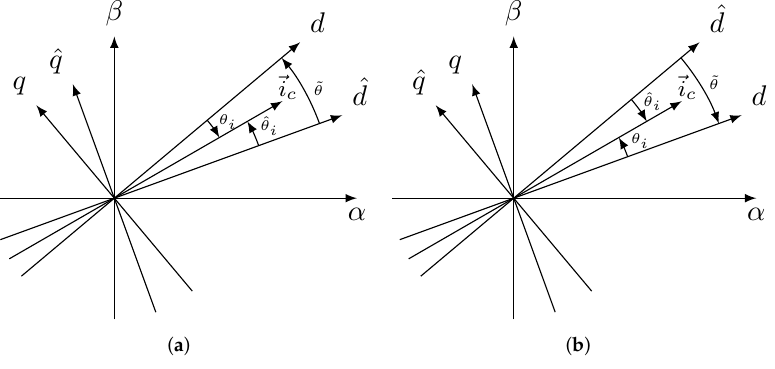
Figure 4. The space position of the high frequency current vector. ( a ) The ˆ d -axis lags the d -axis; ( b ) the d -axis lags the ˆ d